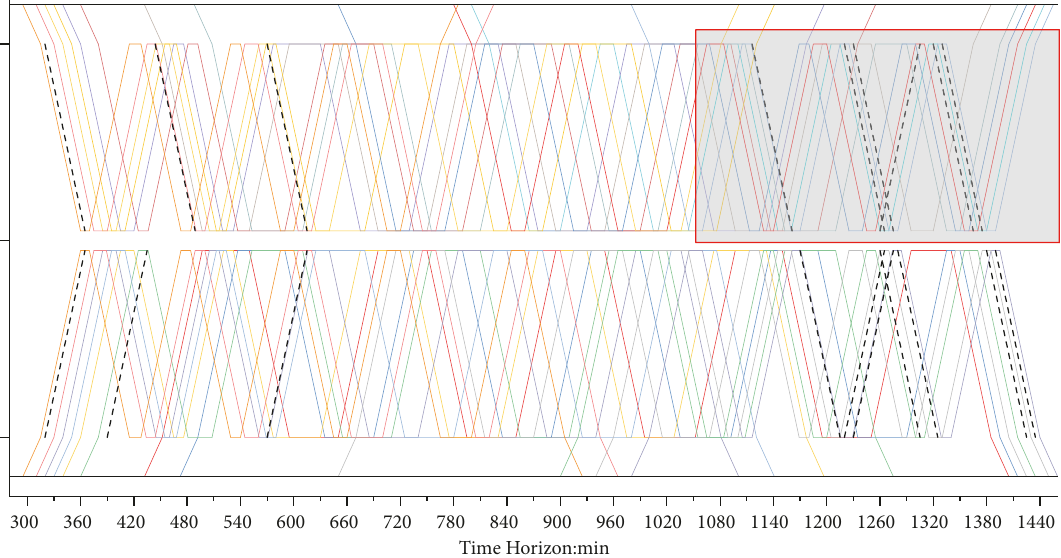
Figure 5: The schedule solution by VT approach.